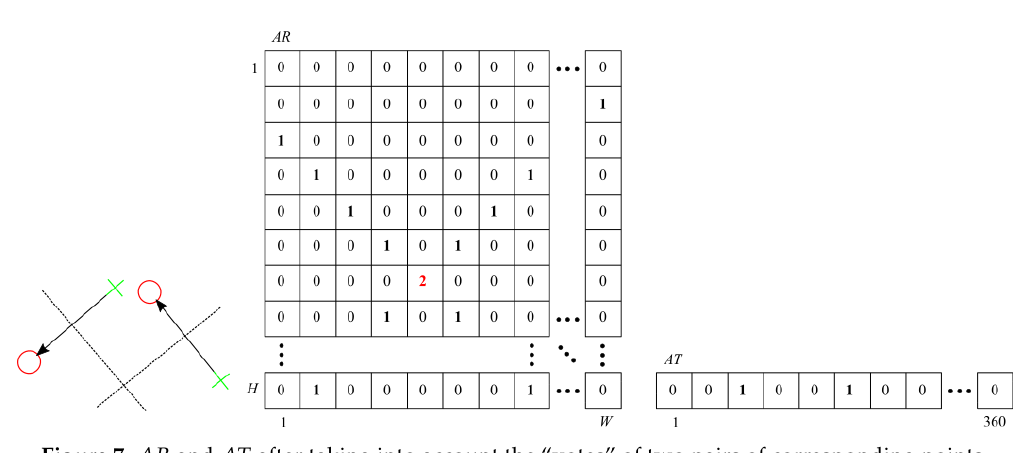
Figure 7. AR and AT after taking into account the “votes” of two pairs of corresponding